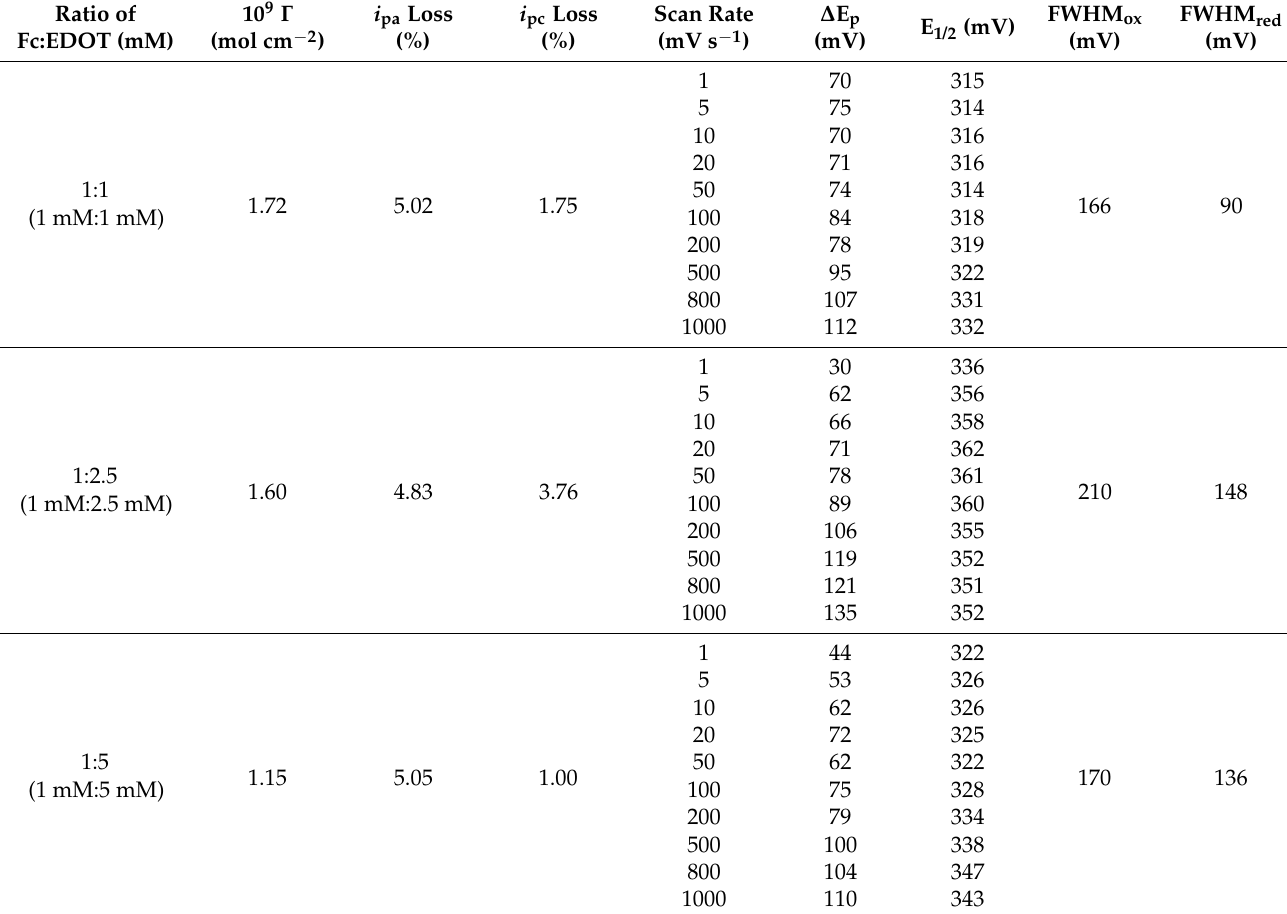
Table 3. Data from the multiple scan rate study on the films of 1-hydroxy-2-[2-(thiophen-3-yl)-ethylamino]ethylferrocene ( 6 ) and EDOT using CV (FWHPH full width at half peak maximum). Ratio of Fc:EDOT